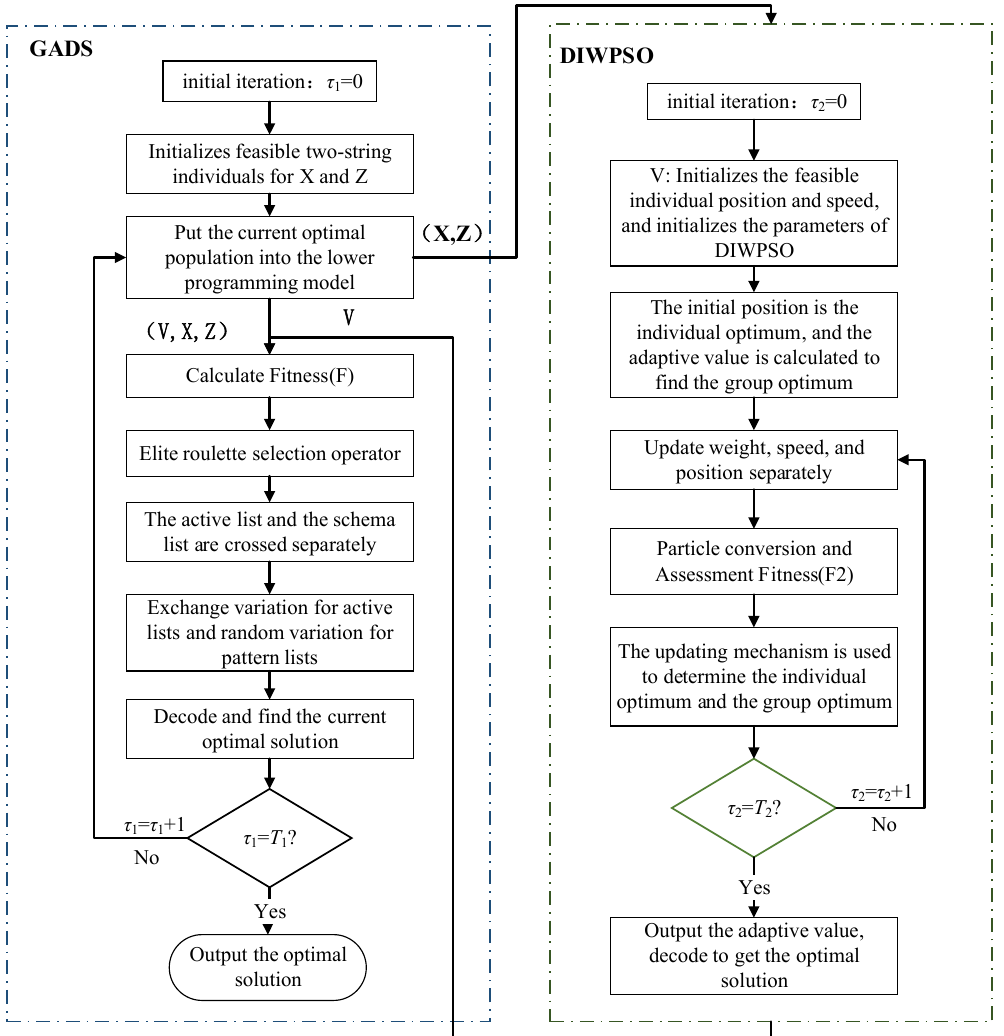
Figure 4. Flow chart of the hybrid algorithm.